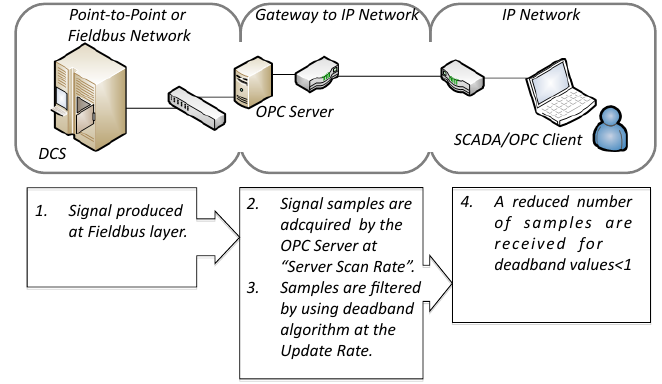
Figure 1. Overview of the steps to receive the samples at the OPC